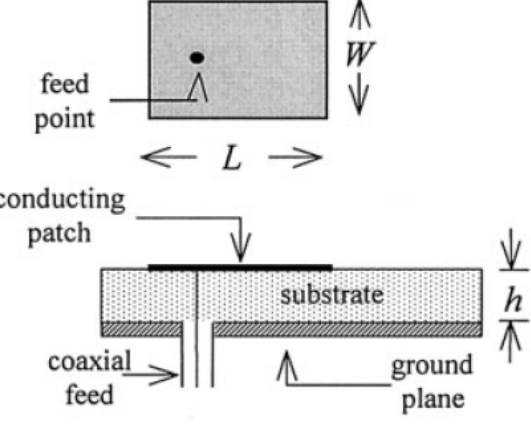
Figure 1. RMSA structure [24].